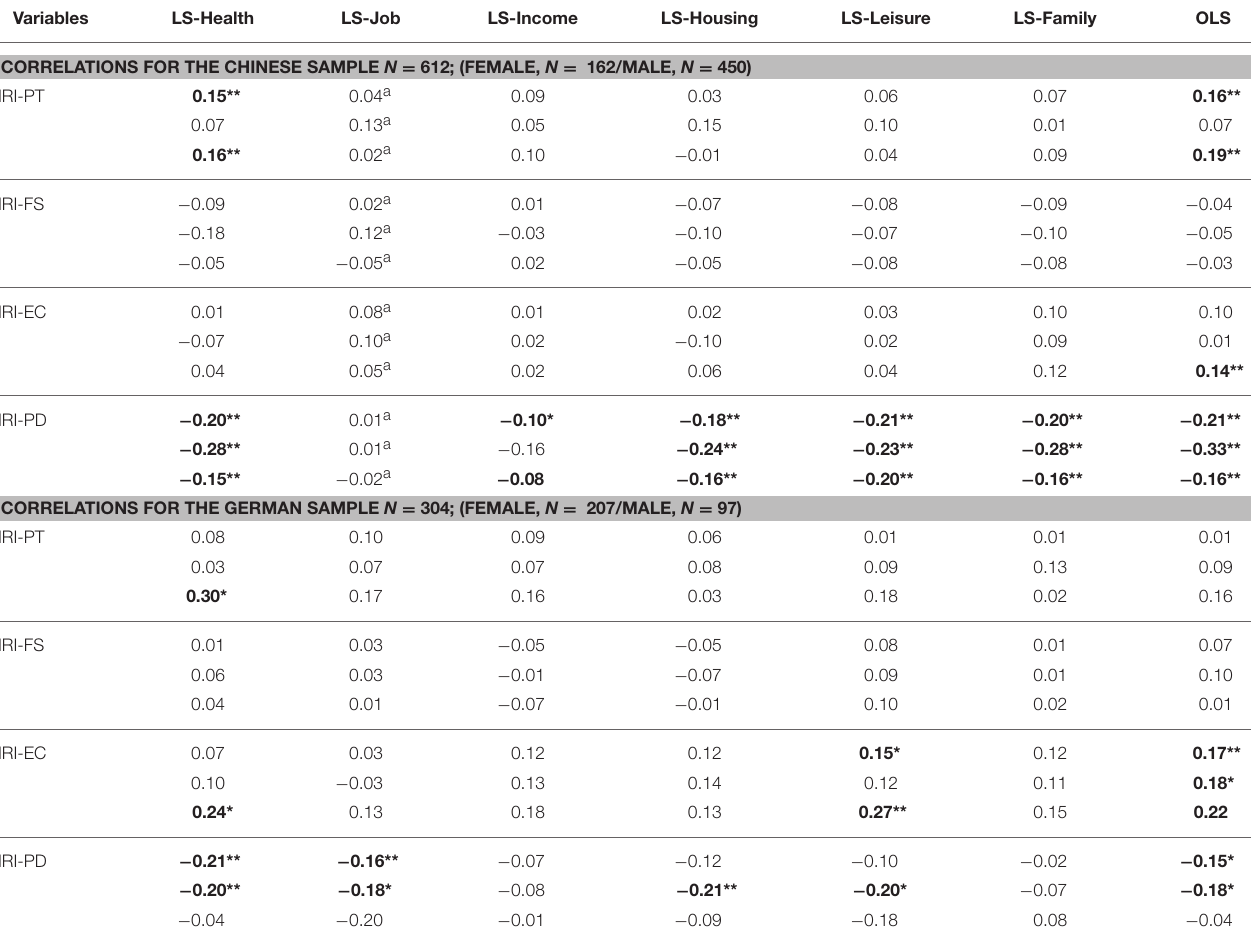
TABLE 4 | Correlations between life satisfaction variables and IRI empathy variables for both samples (top line: complete sample; middle line: female; bottom line: male). Variables